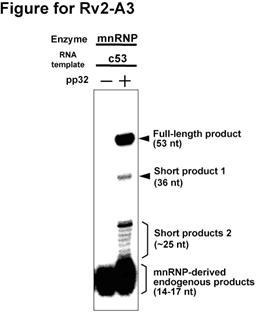
DOI:
http://dx.doi.org/10.7554/eLife.08939.014